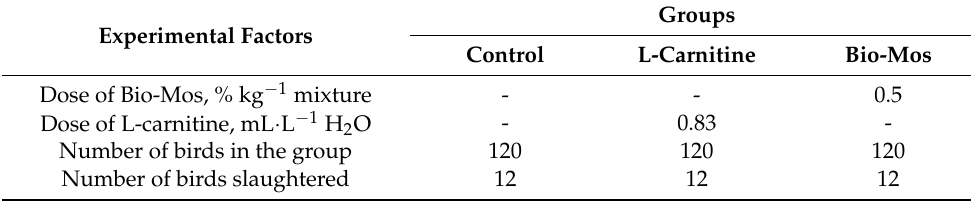
Table 3. Experimental